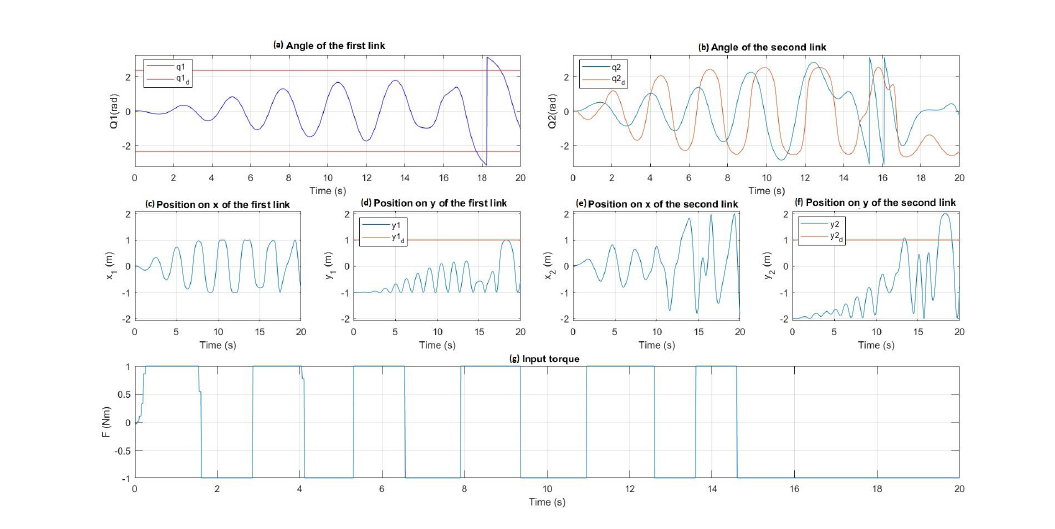
Figure 3. Results of the proportional–derivative (PD) controller by Spong to the swing-up problem. In the first row, the positions of the angle of the first ( a ) and the second ( b ) joints are shown in radians. The red line in ( a ) is the moment when the other controller starts to control for the balancing problem. The red line in ( b ) is the desired angle of the second link. In the second row, there are the positions on x ( c ) and y ( d ) of the first link and on x ( e ) and y ( f ) of the second link. The red lines in ( d ) and ( f ) are the goal height (1 m) of the swing-up problem. In the last row, the input torque is represented ( g